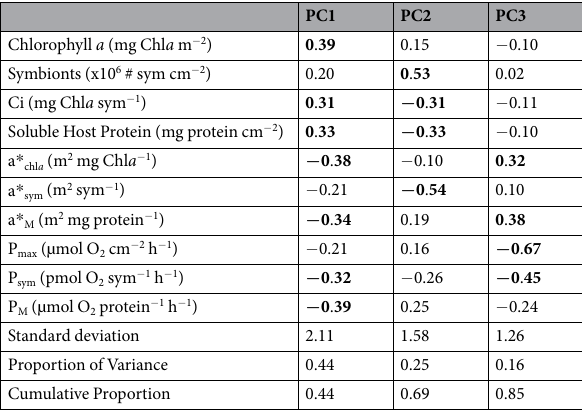
a * sym and P sym than O . faveolata , especially in summer (Fig. 3b), while O . annularis showed higher values for a * M but also for P M and P max , relative to M . cavernosa (Fig. 3b). As mentioned, the smallest differences between sea- sonal phenotypes were found for O . annularis . Scaling quotient of temperature (Q ). Temperature enhanced all metabolic rates along an optimal range, 10 also negatively affecting some processes when increased above a particular threshold (Fig. 4). Adverse effects on coral photosynthesis were observed for all species and phenotypes above 32 °C, but no negative impact was detected for coral respiration over the range of temperature investigated (Fig. 4a–d). Coral photosynthesis and res- piration showed higher temperature scaling factors, Q 10 , in the summer phenotypes (Tables S3–S4), which resulted